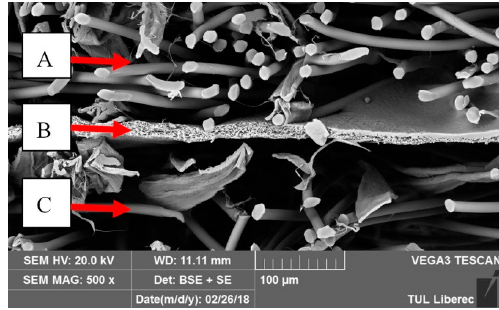
Figure 1. The water barrier consists of three laminate layers, i.e., nonwoven layer ( A ), nanofiber membrane ( B ), and nonwoven layer ( C ).